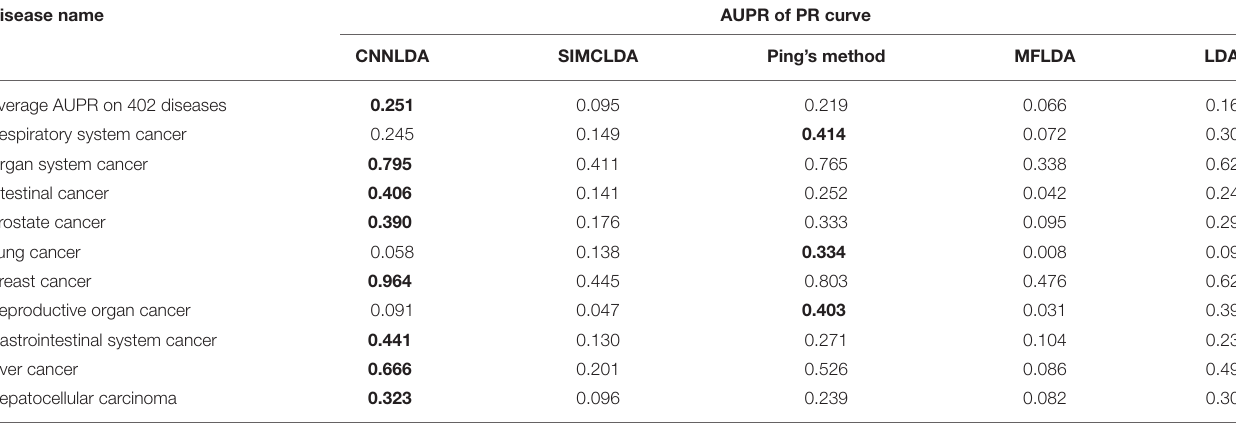
TABLE 2 | AUPRs of PR curves of CNNLDA and other methods for all of the diseases and 10 well-characterized diseases. Disease name